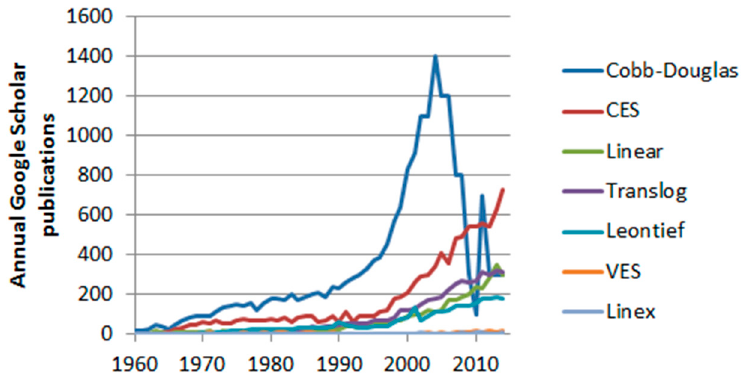
Figure 1. Google-Scholar search 5 March 2015 of publications that reference each production function.